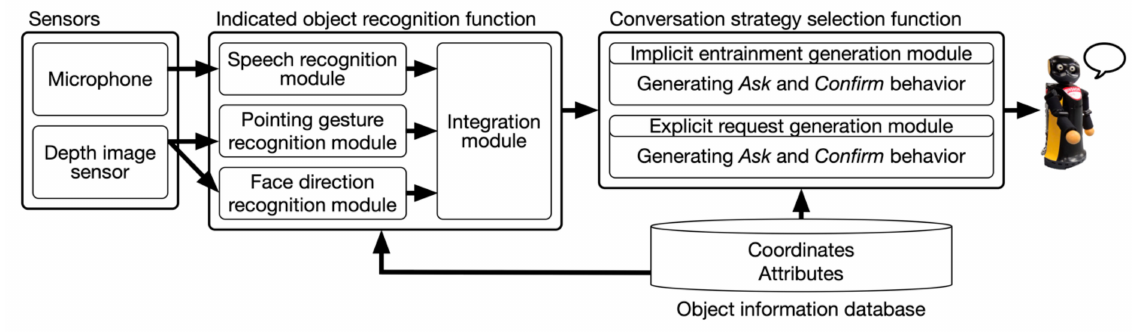
Figure 4. System architecture to recognize an object to which a user referred and to make the Ask and Confirm behavior of the